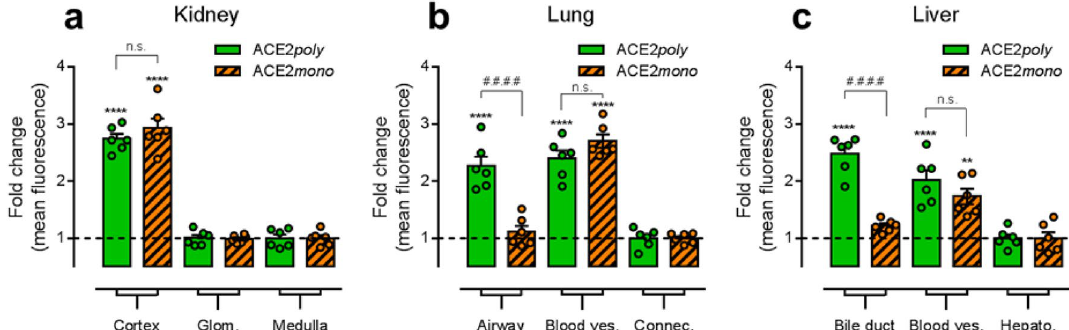
Figure 4. Quantification of differential expression of full-length ACE2 and the short dACE2 isoform in specific structures of human tissues. Graphical output shows the fold change in mean fluorescence observed for the respective secondary antibodies used to visualise ACE2 poly and ACE2 mono in distinct anatomical structures of the human tissue sections shown in Fig. 3. For each structure, n = 6 from ≥ 2 tissue sections. ( a ) Fold change in mean fluorescence observed for ACE2 poly and ACE2 mono in kidney cortex and glomeruli (Glom.), versus the normalised mean fluorescence observed in the renal medulla. ( b ) Fold change in mean fluorescence observed for ACE2 poly and ACE2 mono in airway structures and blood vessels (Blood ves.) of the lung, versus the normalised mean fluorescence observed in the connective tissue (Connec.). ( c ) Fold change in mean fluorescence observed for ACE2 poly and ACE2 mono in liver bile ducts and blood vessels (Blood ves.), versus the normalised mean fluorescence observed in liver hepatocytes (Hepato.). All data show mean ± SEM with individual data points shown. Statistical analyses of data included a one way ANOVA with multiple comparisons using Tukey’s correction. Statistical significance was determined where p < 0.05. **** or #### = p < 0.0001; ** = p < 0.01; n.s. = no significant